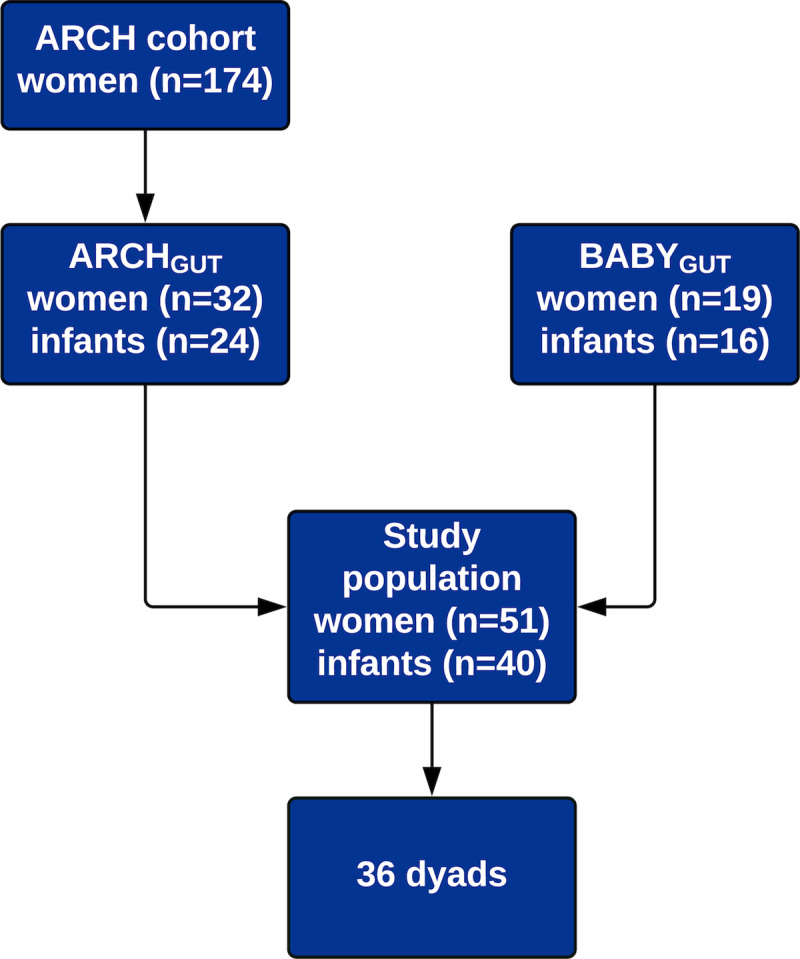
Flowchart of the selection of the study population.